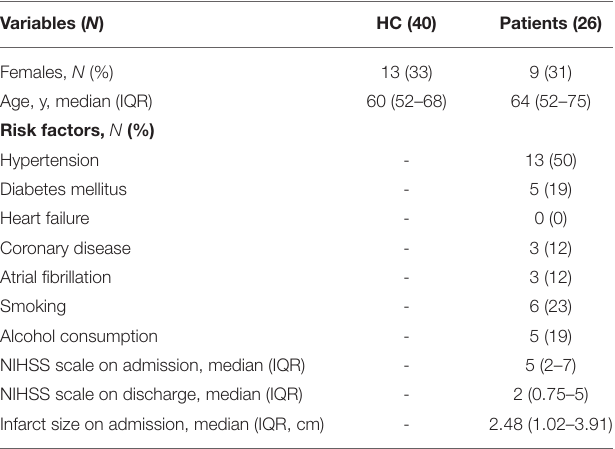
TABLE 1 | Demographics of the included patients and healthy controls